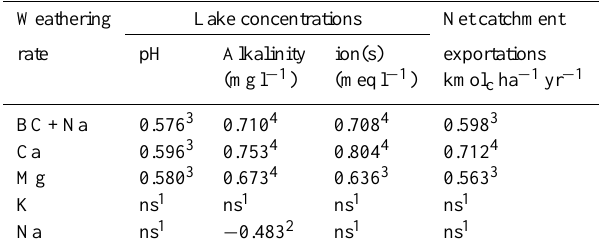
Table 6. Correlation coefficients ( r ) between ions weathering rates estimated with PROFILE and pH, alkalinity, ion concentrations in lakes, and net catchment exportations.